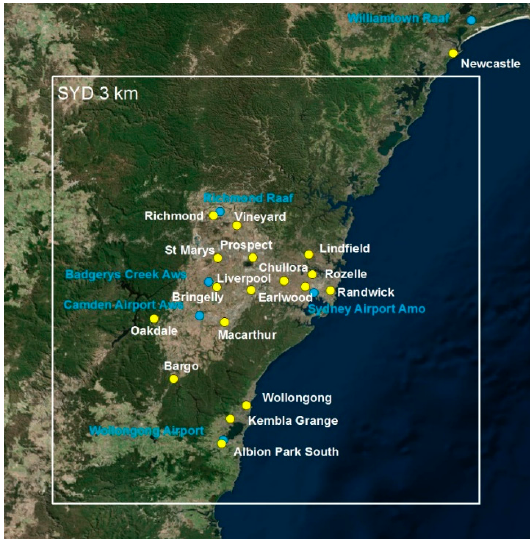
Figure 4. Location of 18 OEH air quality monitoring stations (yellow dots) and six BOM weather stations (blue dots) used for model performance evaluation. All stations are within the innermost Sydney domain (SYD) used for CCAM-CTM simulation with a horizontal resolution of 3 km with two exceptions of OEH Newcastle station and BOM Williamtown RAAF.